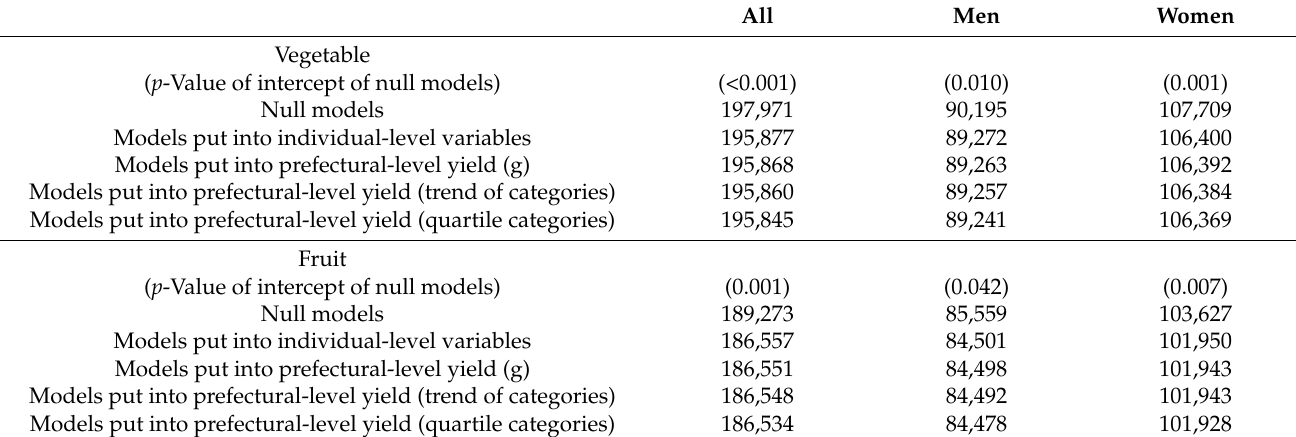
Table A1. Goodness of fit for each model of Table